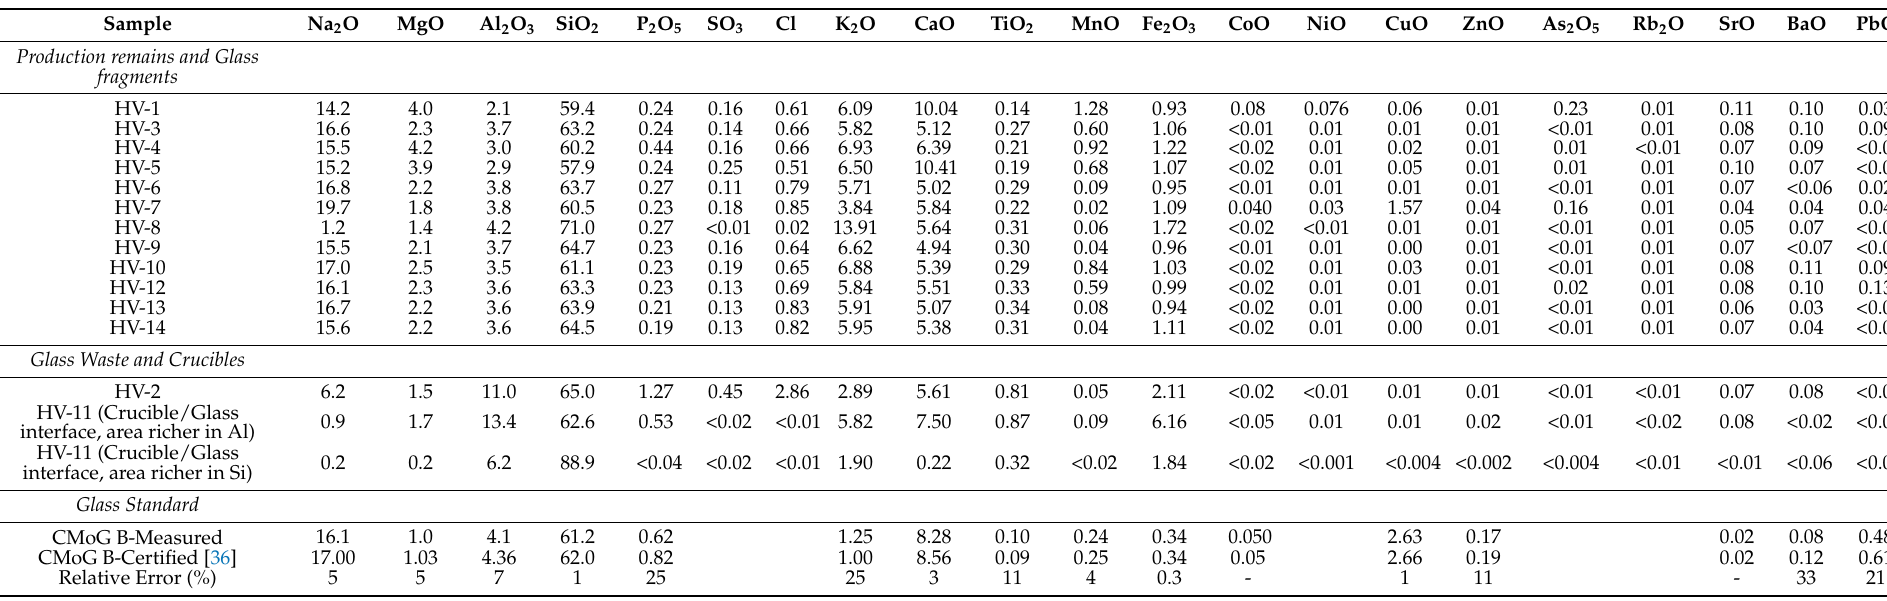
Table 2. Chemical composition of the samples from Horno del Vidrio, Granada, determined by µ -PIXE, in weight percent of